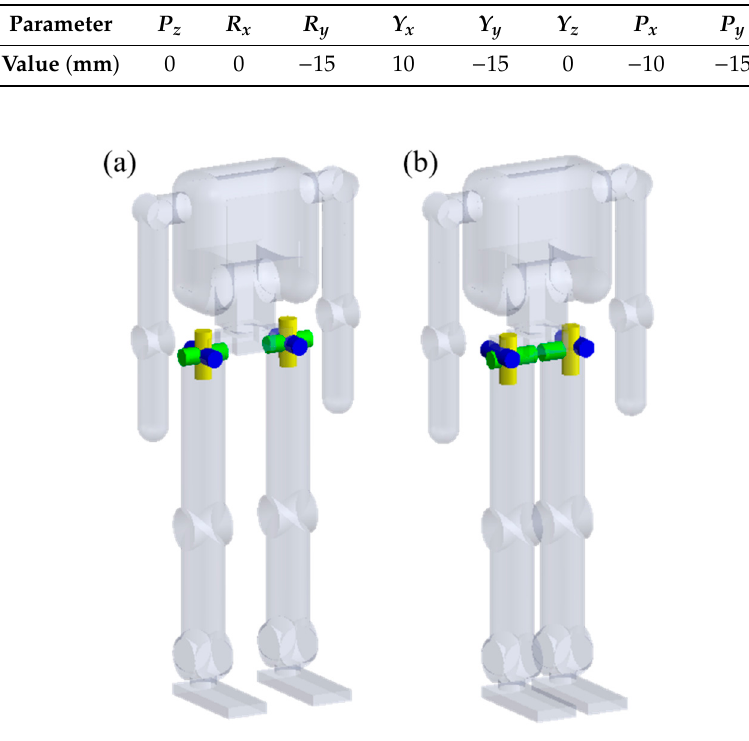
Figure 7. Hipjointconfigurationof( a )theoriginalmodeland( b )themodelafterthesecondoptimization. Figure 7. Hip joint configuration of ( a ) the original model and ( b ) the model after the second optimization.